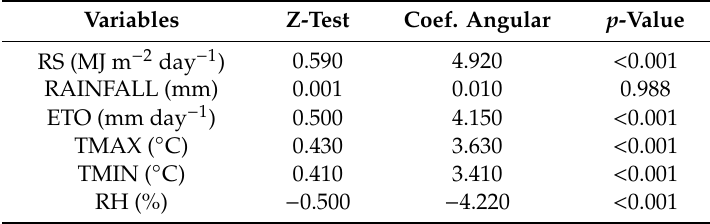
Table 5. Summary of the results of the non-parametric Mann–Kendall test (Z-test) in the annual series of meteorological variables in the period from 1980 to 2013 in the MATOPIBA region.